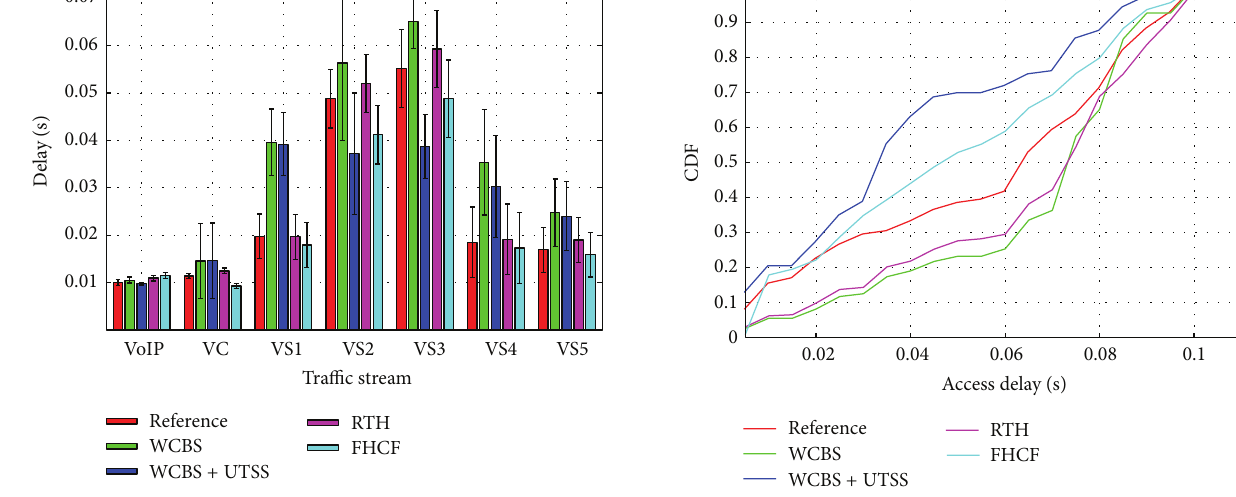
Figure 12: Mean access delay. Figure 13: Access delay CDF of VS3 traffic